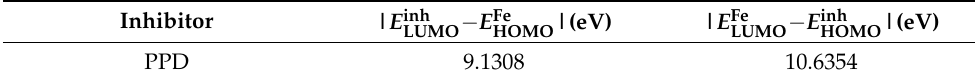
Figure 10. Quantum chemical descriptors for PPD used by DFT/B 3 LYP/6-31G basis set. Table 6. E HOMO − E LUMO interactions for MS–(PPD) complex.